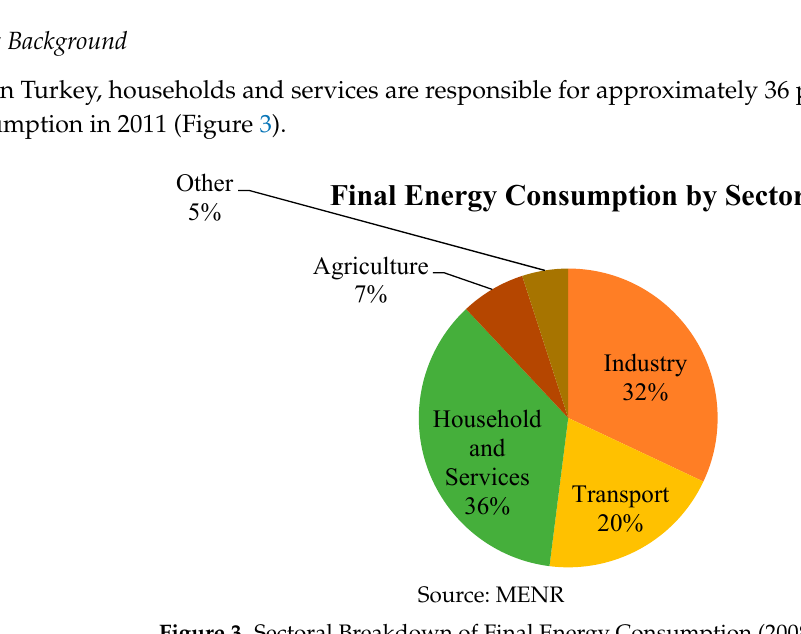
Figure 3. Sectoral Breakdown of Final Energy Consumption (2008).